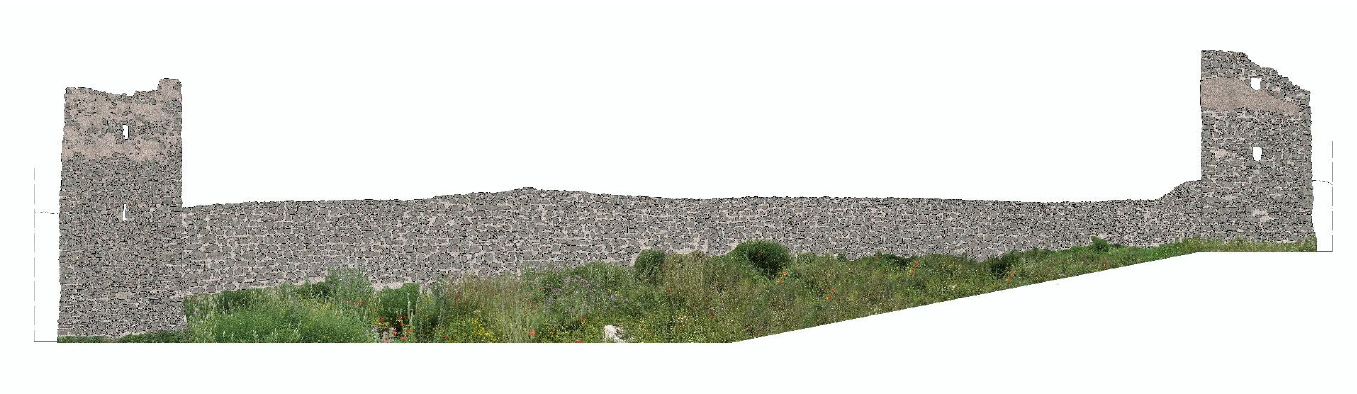
Figure 12: orthophoto-mosaics of the south